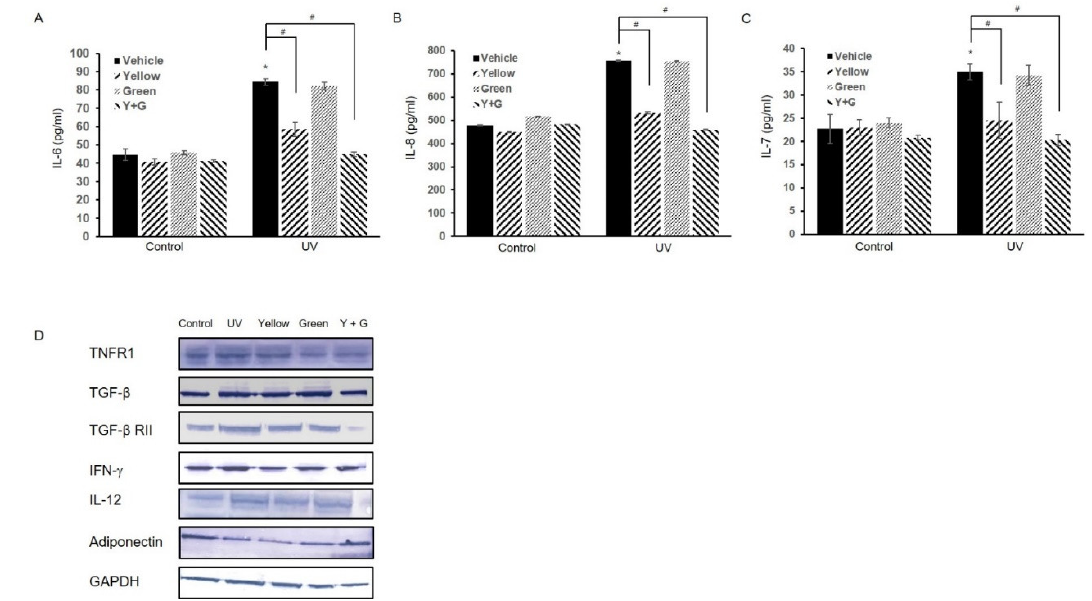
Figure 3. IPL application attenuates proinflammatory cytokine secretion and protein expression induced by UVB irradiation. Cell lysates were applied to analysis with specific ELISA kits to detect secreted ( A ) IL-6, ( B ) IL-8, and ( C ) IL-7. ( D ) The protein expression of tumor necrosis factor receptor 1 (TNFR1), transforming growth factor beta (TGF-β), TGF-β RII, interferon gamma (IFN-γ), interleukin (IL)-12, and adiponectin was detected by Western blotting. The full blotting data are presented in Figure S3. The data are presented as the means ± SDs of the values obtained in 3 independent experiments (N = 3). # p < 0.001 compared to the UVB-treated group; * p < 0.001 compared to the vehicle-treated (control) group.